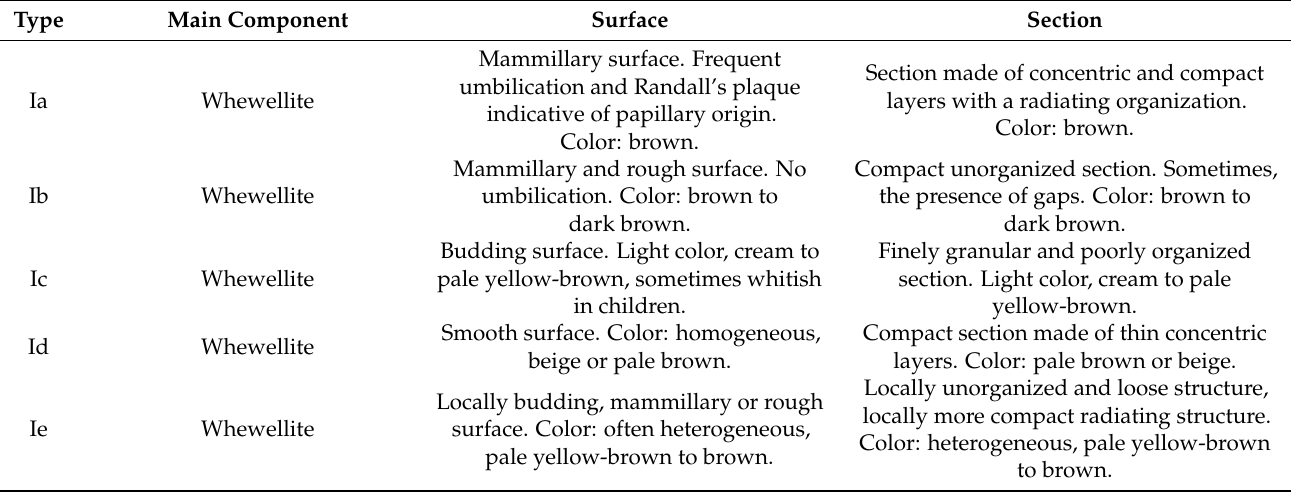
Table 1. Morpho-constitutional classification of urinary calculi, adapted from